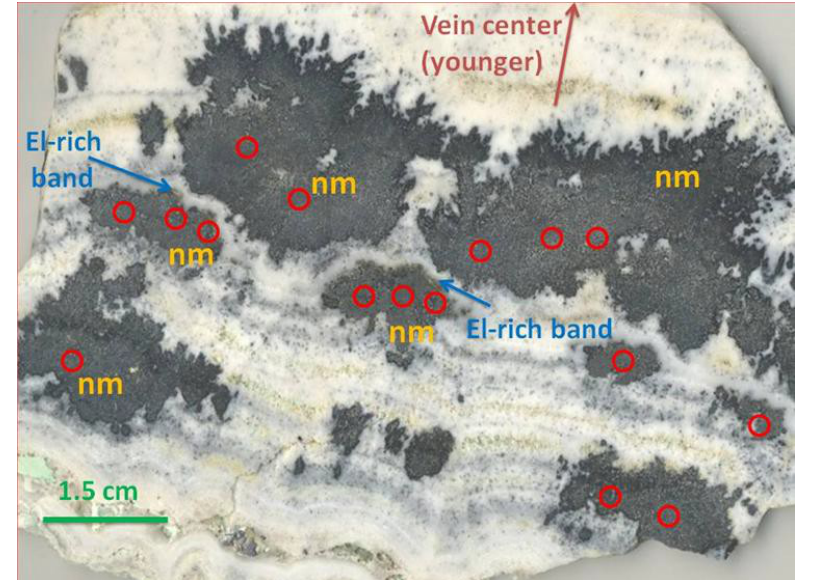
Figure 4. Photograph of large naumannite (nm) dendrites in multiple bands from the Bell vein, Buckskin National Deposit, Nevada (National District). A single electrum rich-band is labeled, and it has a very similar morphology to those documented from the Sleeper deposit, but clearly represents one finite episode of essentially electrum-only deposition. Red circles denote location of electrum grains within naumannite dendrites, and their distribution suggests that there were at least three gold-rich depositional events while naumannite dendrites were growing. Additional details of Buckskin National mineralogy and textures can be found in Vikre [20] and Saunders et al .